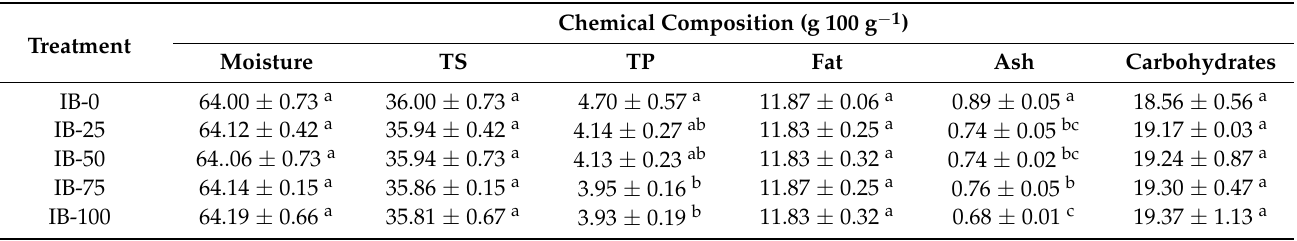
Table 2. The proximate chemical composition of ice cream incorporating